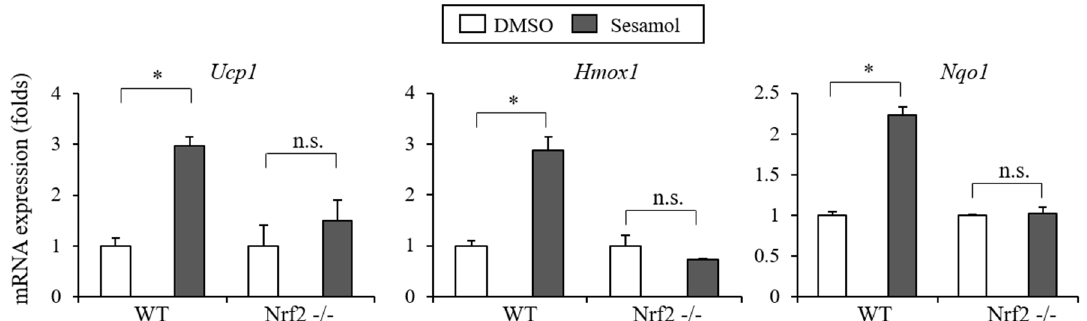
Figure 7. Nrf2 is essential for the sesamol-mediated Ucp1 induction. Induction of Ucp1 and Nrf2 target genes by sesamol was compromised in the absence of the Nrf2 expression. Nrf2 knockout mouse embryonic fibroblasts (Nrf2 KO MEF) or Nrf2 wild type cells (Nrf2 WT) were treated with sesamol for 12 h and relative levels of Ucp1 , Hmox1 , and Nqo1 were measured by real-time PCR. Data are means ± standard deviations ( n = 3). Data represent means ± s.e.m. and are representative of three independent experiments. Statistical significance was determined relative to a control using the Student’s t -test (ns, not significant; * p < 0.05). WT, Nrf2 wild type cells ; Nrf2 -/-, Nrf2 KO MEF.